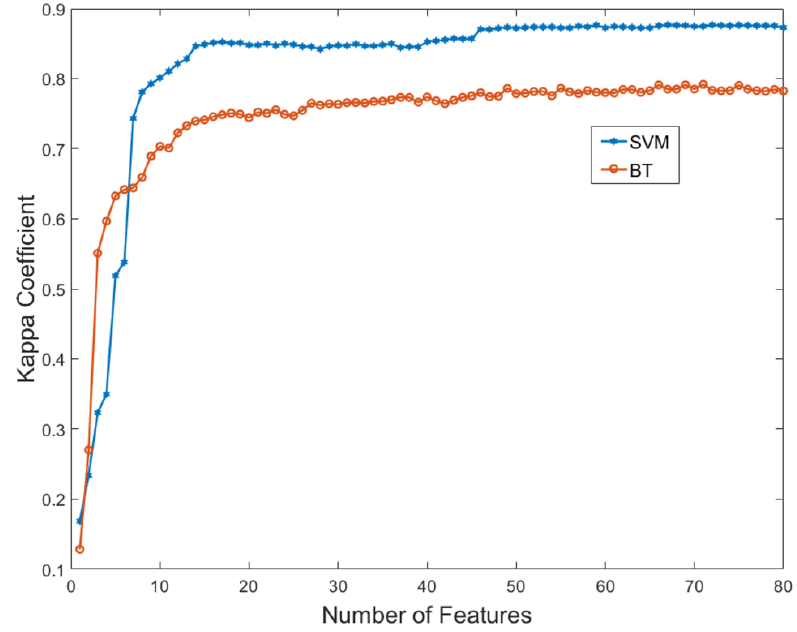
Figure 8. Kappa coefficient evolution for an increasing number of features for both SVM and RF crop type classifications.